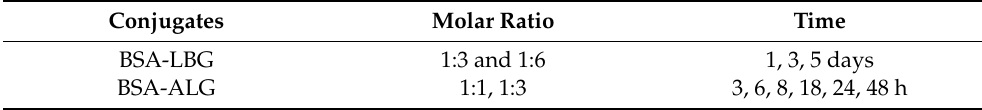
Table 1. Experimental parameters of BSA conjugates.